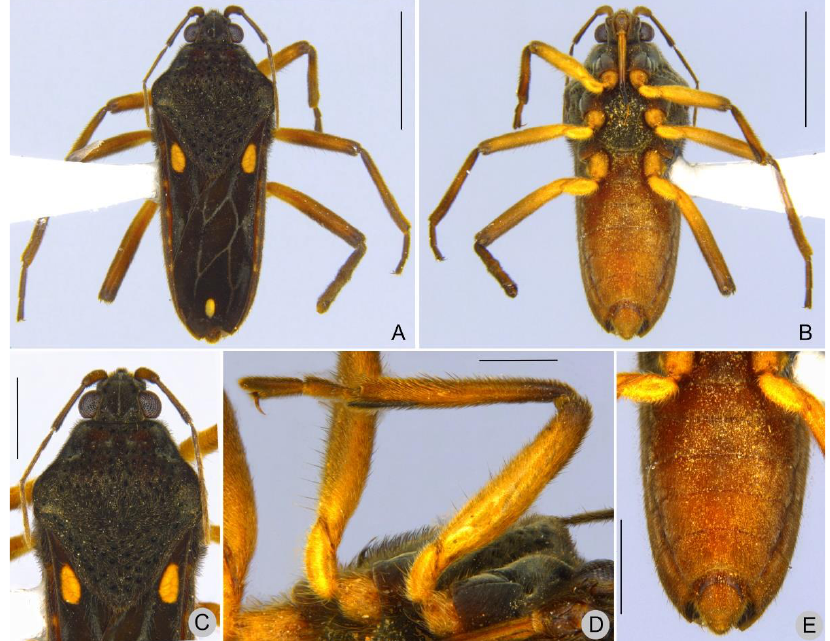
Figure 2. Paravelia luisi sp. nov., paratype male. ( A ). Habitus, dorsal view. ( B ). Habitus, ventral view. ( C ). Head, pronotum, part of the antennae and of the forewings, dorsal view. ( D ). Fore and mid legs, ventral view. ( E ). Abdominal sterna, ventral view. Scale bars: 2.0 mm ( A , B ), 1.0 mm ( C , E ), 0.5 mm ( D ).